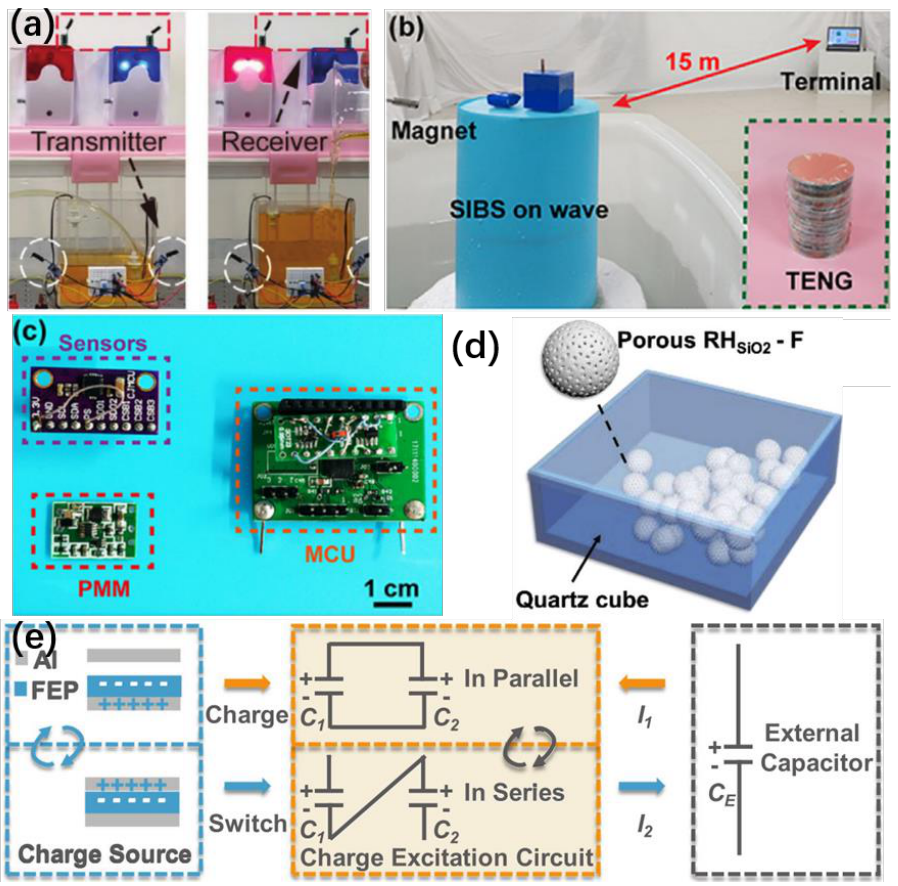
Figure 11. ( a ) Photograph of low and high-water level alarm (reproduced with permission from [153]. Copyright 2021 Wiley-VCH GmbH, Weinheim, Germany). ( b ) Working principle of a contact- separation TENG integrated with the CEC. ( c ) The photos of the PMM, MCU and sensors (repro- duced with permission from [154]. 2020 Wiley-VCH GmbH, Weinheim, Germany). ( d ) Schematic diagram showing the RH SiO2 -F particles encapsulated in a quartz cube (reproduced with permission from [155]. Copyright 2019 Elsevier Ltd., Singapore). ( e ) Demonstration of the SIBS in a simulated wave environment. The inset is the photo of the multilayered TENG (reproduced with permission from [156]. Copyright 2019 Elsevier Ltd., Singapore).